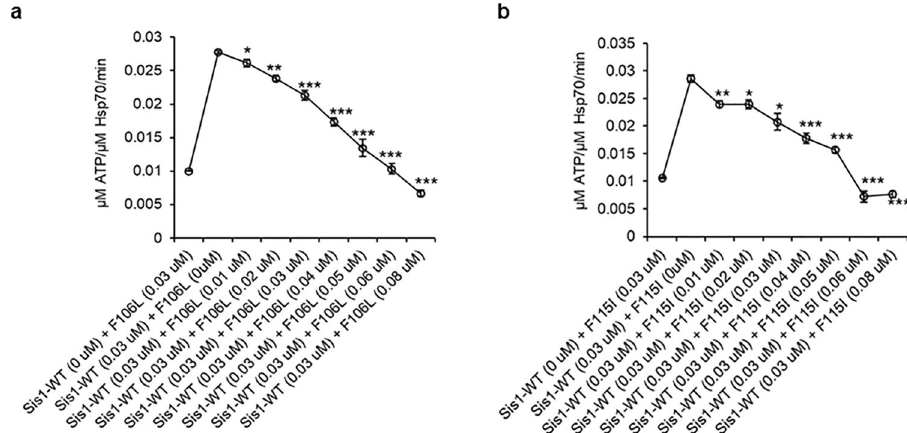
Fig. 6 | LGMDD1 G/F domain mutants inhibit Sis1-WT induced ATPase activity ofSsa1. StimulationofSsa1ATPaseactivityinthepresenceofRnq1seedsformedat 18°C. Sis1-mutants (Sis1-F106L a , or Sis1-F115I b ) (0 – 0.08 µ M) were titrated with Sis1-WT (0.03 µ M) in the presence of Ssa1 (1 µ M) and ATP (1mM). The fraction of ATPconvertedtoADPwasdeterminedat30min.Datarepresentedasmean±SEM, n =3 biologically independent samples. For a , b ; values of the